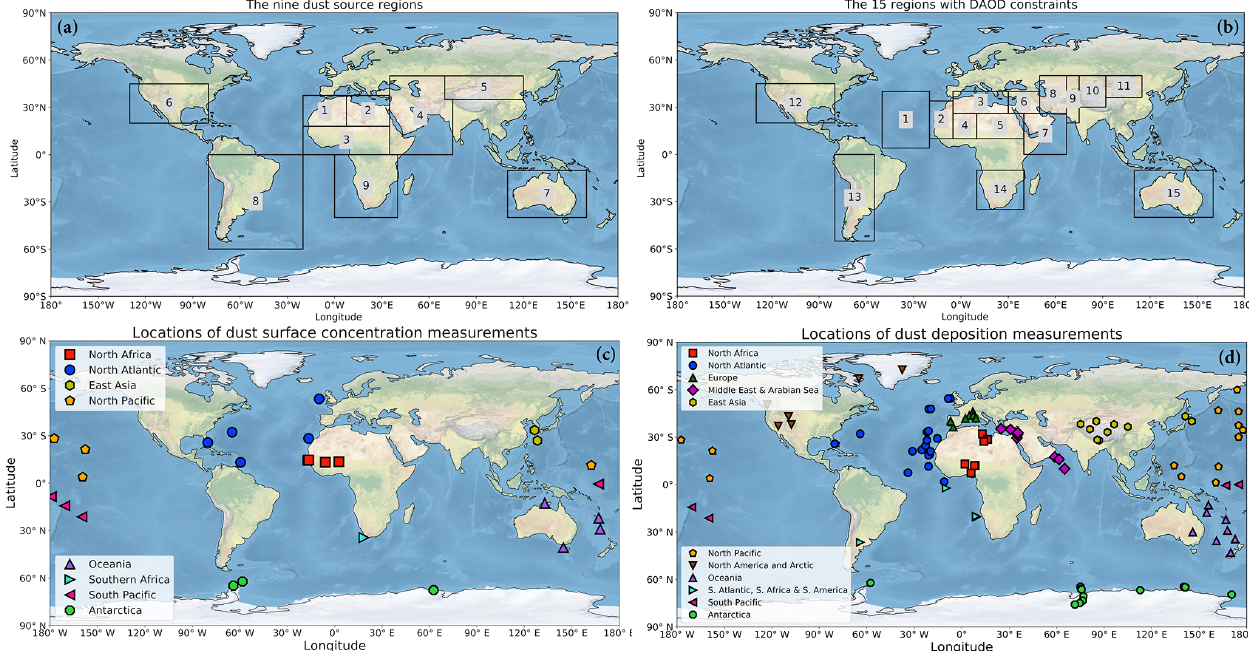
Figure 2. Coordinates of (a) the nine main source regions and (b) the 15 observed regions with constraints on the regional dust aerosol optical depth (DAOD), (c) dust surface concentration measurements, and (d) deposition flux measurements used in this study. The coordinates of the nine source regions are as follows: (1) western North Africa (20 ◦ W–7.5 ◦ E; 18 ◦ N–37.5 ◦ N), (2) eastern North Africa (7.5–35 ◦ E; 18– 37.5 ◦ N), (3) the Sahel (20 ◦ W–35 ◦ E; 0–18 ◦ N), (4) the Middle East and central Asia (which includes the Horn of Africa; 35–75 ◦ E for 0–35 ◦ N, and 35–70 ◦ E for 35–50 ◦ N), (5) East Asia (70–120 ◦ E; 35–50 ◦ N), (6) North America (130–80 ◦ W; 20–45 ◦ N), (7) Australia (110–160 ◦ E; 10–40 ◦ S), (8) South America (80–20 ◦ W; 0–60 ◦ S), and (9) southern Africa (0–40 ◦ E; 0–40 ◦ S). The coordinates and seasonal DAOD of the 15 observed regions are listed in Table 2. Symbols in (c) and (d) denote groupings of observations by different regions. Made with Natural